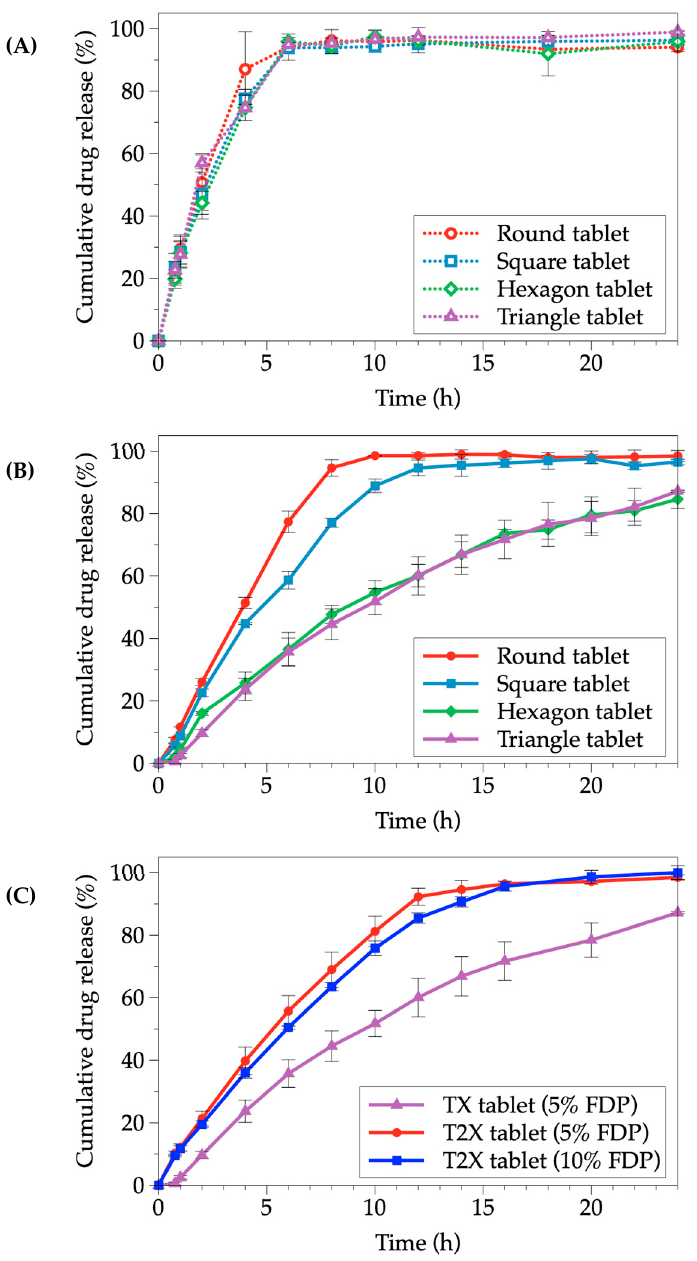
Figure 8. Cumulative drug release profiles of FDP-loaded 3D-printed tablets; ( A ) the tablets without an outer compartment, ( B ) the tablets with an outer compartment, ( C ) the tablets with triangle-shaped inner compartments having different inner compartment volumes or different drug concen ‐ trations.